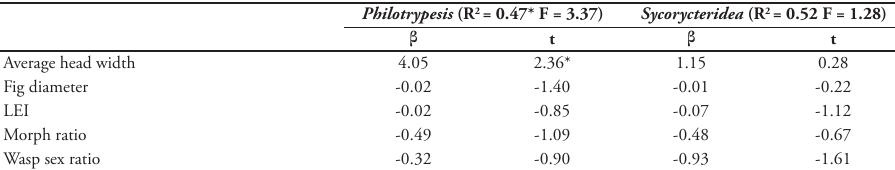
Means are given ± SE. Numbers with different letters indicate significant Table 6. Result of the multiple linear regression model with the male exit proportion as dependent vari- ables.